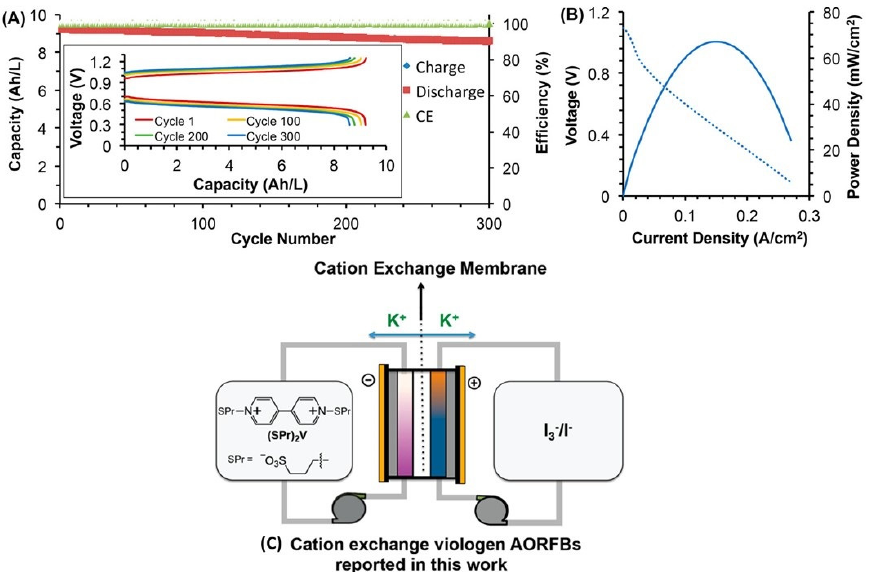
Figure 9. ( A ) Extended cycling data of the (SPr) 2 V/KI AORFB showing charge-discharge capacity and coulombic efficiency during galvanostatic cycling at 60 mA/cm 2 . Inset: Representative charge and discharge curve from the experiment. ( B ) Polarization (primary axis) and power density data (secondary axis) collected at 100% SOC. Conditions: negolyte, 0.5 M (SPr) 2 V in 2.0 M KCl; posilyte, 2.0 M KI in 2.0 M KCl, Nafion 212 cation exchange membrane. ( C ) Battery design of cation exchange viologen AORFBs. Adopted with permission from CS Energy Lett. 2018, 3, 3, 663–668 [117]. Copyright © 2022, A3merican Chemical Society.